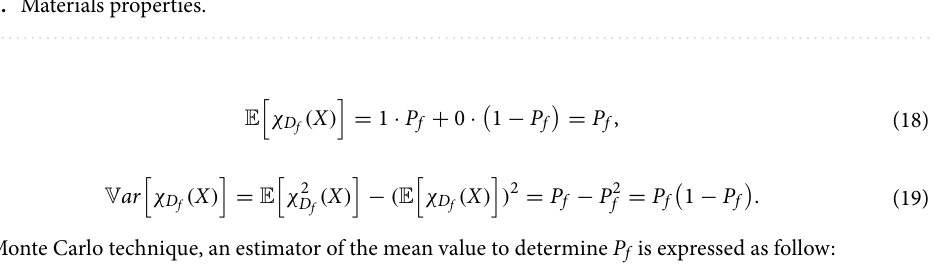
Table 1. Materials